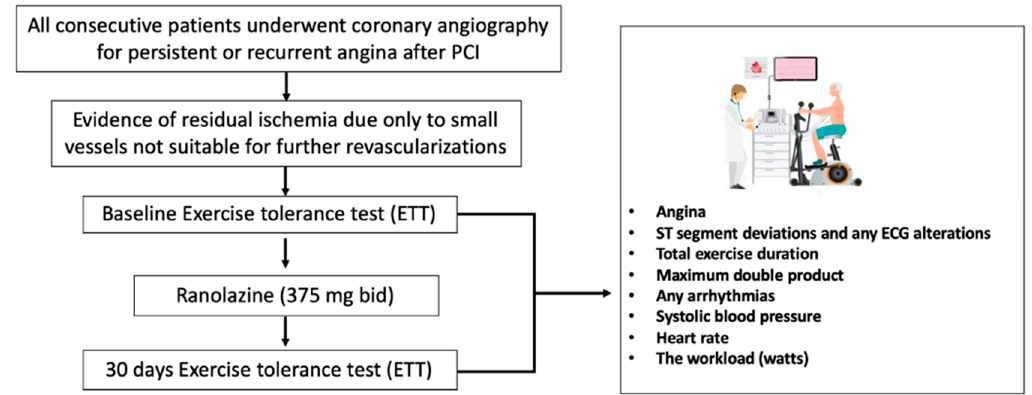
Figure 1. The figure illustrates the study design and study population (PCI: percutaneous coronary